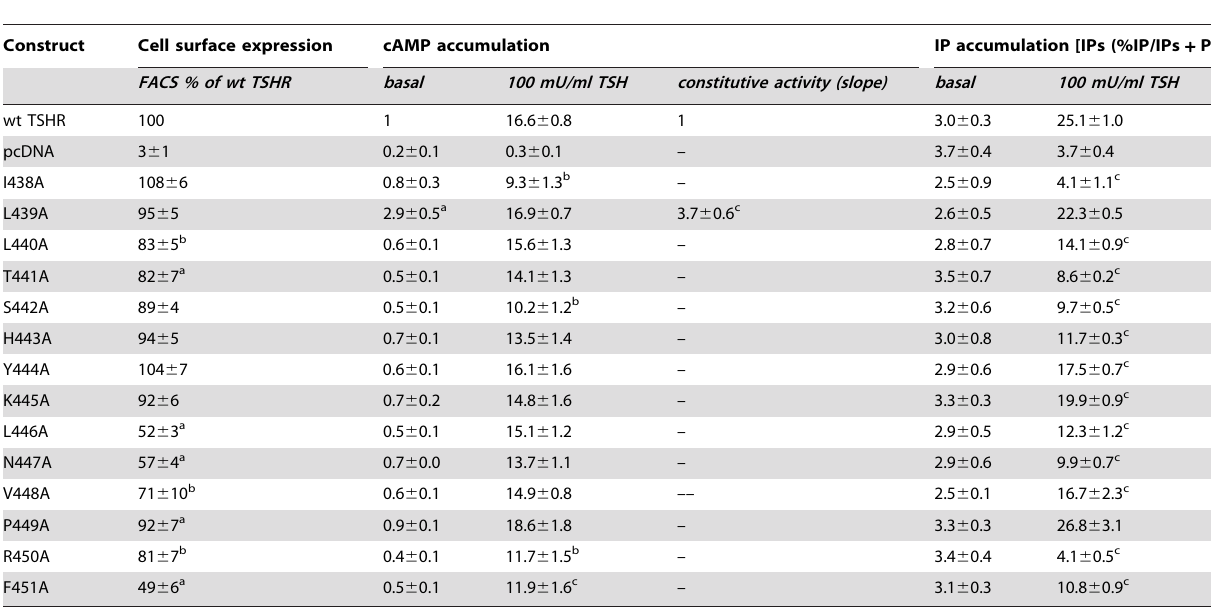
Table 1. Alanine mutagenesis and functional characterization of amino acids in the ICL1 and transitions to the helices 1 and 2.